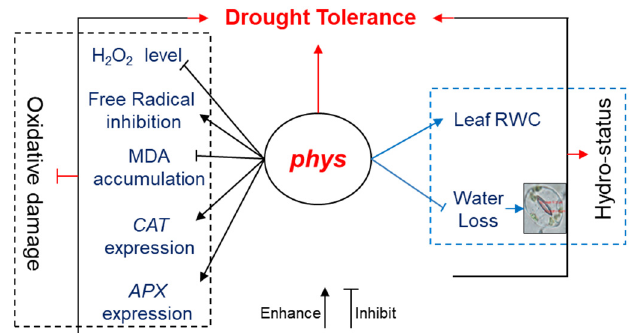
Figure 6. Model of the response of phy mutants under drought stress. This model illustrates the functional response of phyA and phyB1B2 mutants under drought conditions, which are represented in two parts (oxidative damage and hydrostatus) to stimulate drought tolerance. The first is the inhibition of oxidative damage by inhibiting H accumulation, enhancing DPPH free radical in- 2 2 hibition and the gene expression of ROS scavengers and inhibiting MDA accumulation. The second is the stimulation of plant hydrostatus by enhancing leaf relative water content (leaf RWC) and sto- matal closure.